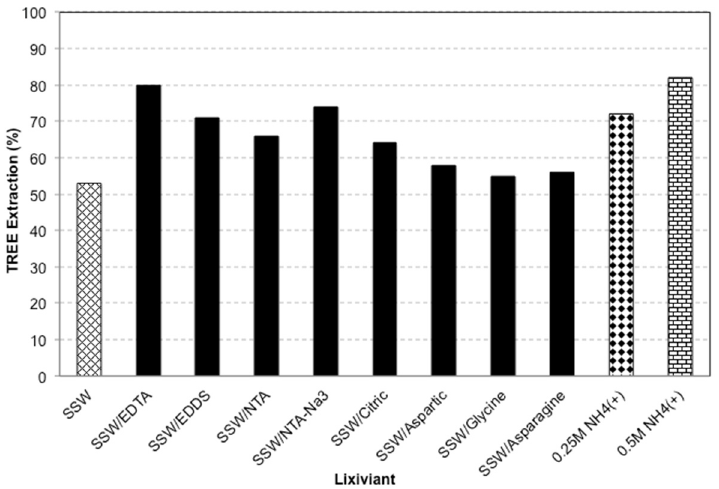
Figure 2. Influence of chelating agent addition on the TREE extraction with simulated seawater (ambient conditions, 30 min, L/S = 2/1, 1:1 chelating agents).